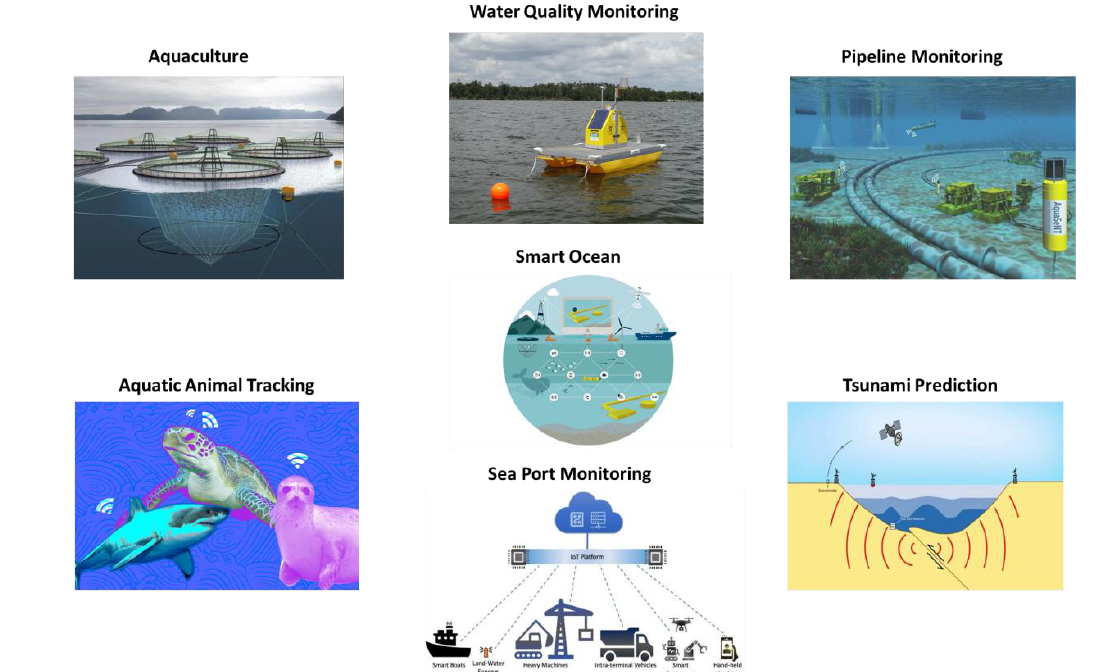
Figure 9. Applications of the IoUT (modified from [5]).